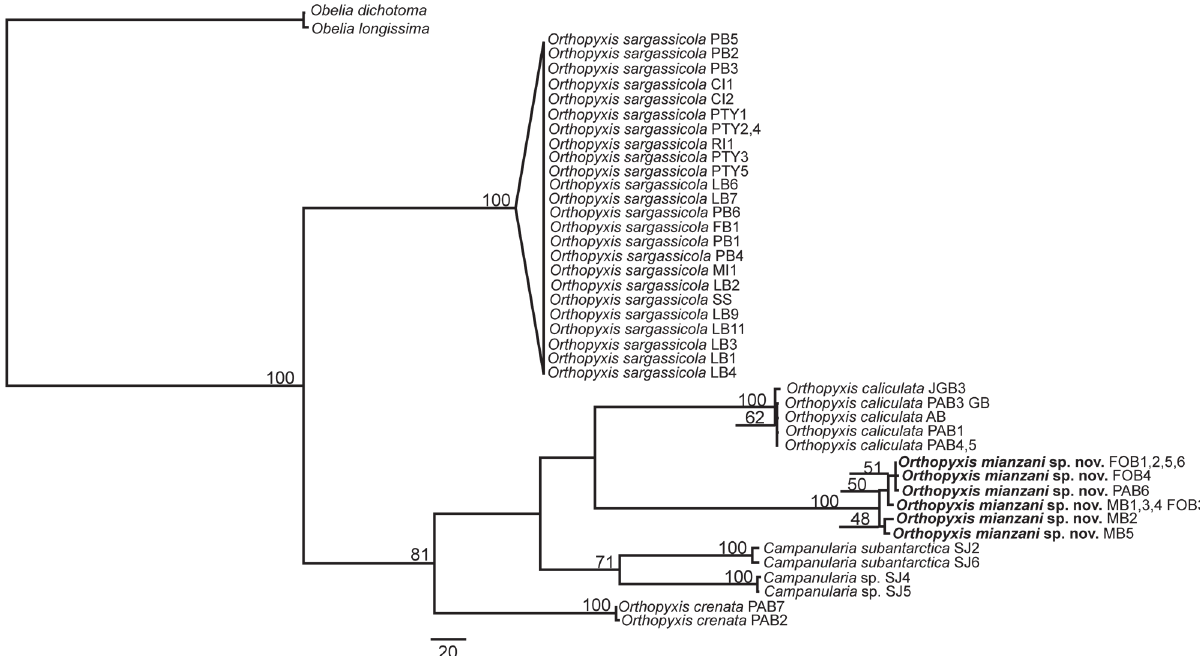
Fig 3. One of the 74 most parsimonious trees based on 16S, COI, ITS1 and ITS2 data. These trees are only different in the position of the haplotypes within O. sargassicola clade, which is collapsed. Bootstrap values are shown for each node. Nodes without numbers indicate support below 50.